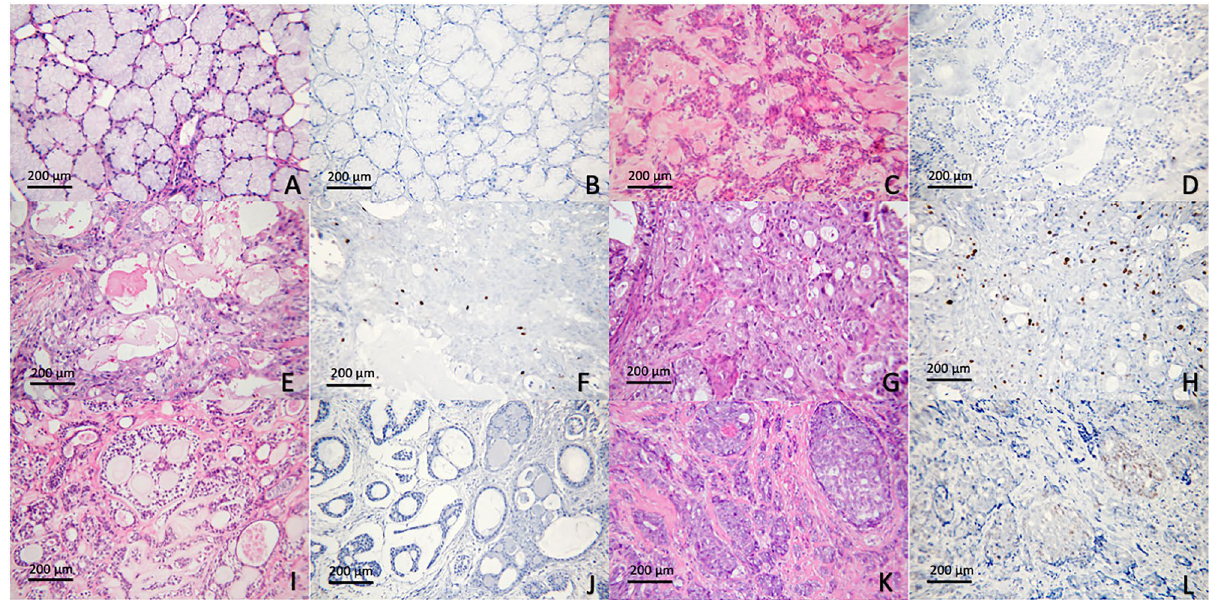
Figure 1. Ki-67 expression in salivary gland neoplasms. ( A , B ) Normal salivary gland tissue; ( C , D ) PA; ( E , F ) low-grade MEC; ( G , H ) high-grade MEC; ( I , J ) ACC, cribriform/tubular subtype; ( K , L ) ACC, solid subtype.